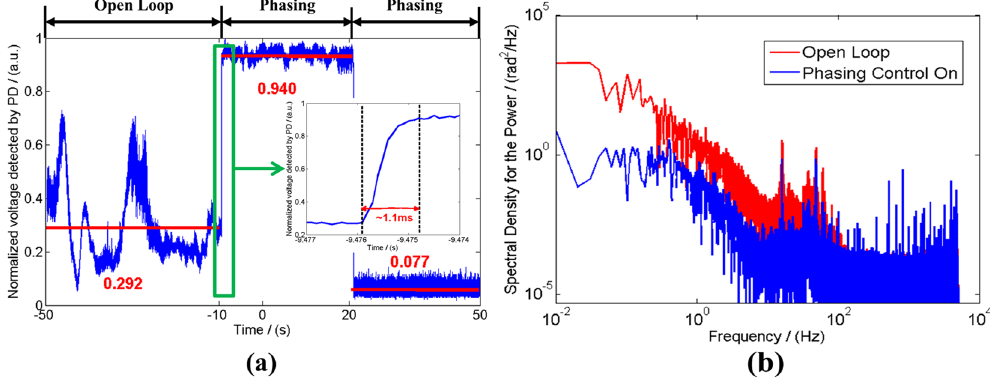
Figure 6. The normalized voltage values detected by the PD along with time and the spectral density of power of phase noise with different situations. ( a ) Time-dependent phasing process. (b ) Spectral